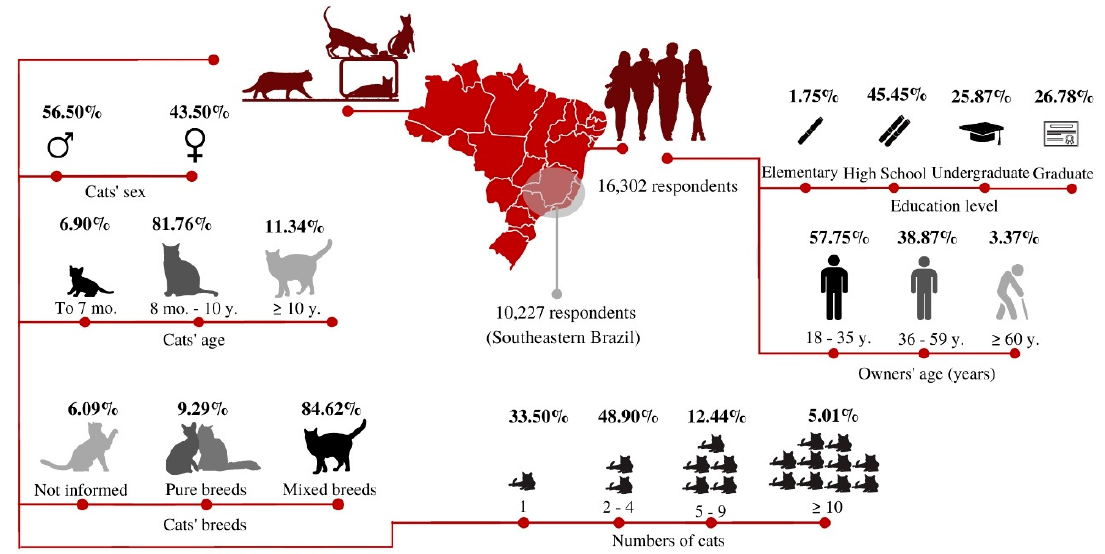
Figure 1. Sociodemographic data of owners and their cats.